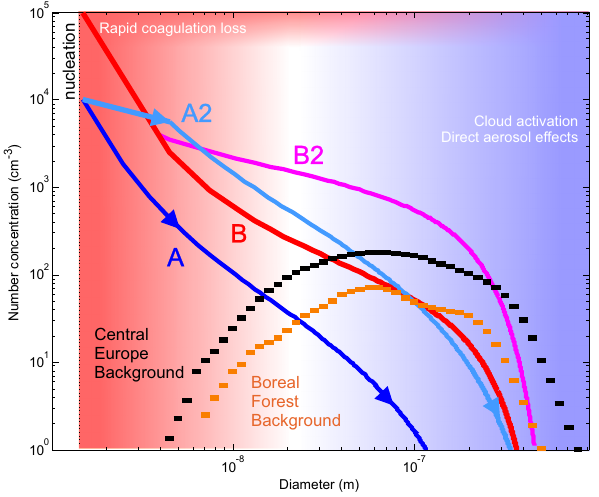
Fig. 2. Analysis of loss/growth processes affecting the NPF-CCN relationship using trajectories of newly-formed particles in the diameter-concentration axis. Different initial particle number con- centrations will produce widely different concentrations in the CCN size range, depending on the background aerosol concentrations (given here as annual median in two environments according to Asmi et al. (2011b) and depicted as dotted lines) and condensation growth rates (comparable to the mean values reported by Yli-Juuti et al., 2011). A nucleation event taking place in a relatively clean region will have little influence on CCN concentrations when nucle- ated particles are growing slowly in size (1nm h − 1 , trajectory A). If, however, nucleation is accompanied by a higher particle growth rate in the first 1.5 hours (5nm h − 1 , trajectory A2), concentrations in the CCN size range are considerable. A strong nucleation event in a polluted region has a low CCN production efficiency due to losses (trajectory B). If, however, concentrations of pre-existing larger par- ticles decrease after a few hours (e.g. precipitation or mixing event, trajectory B2), CCN resulting from atmospheric nucleation become much more